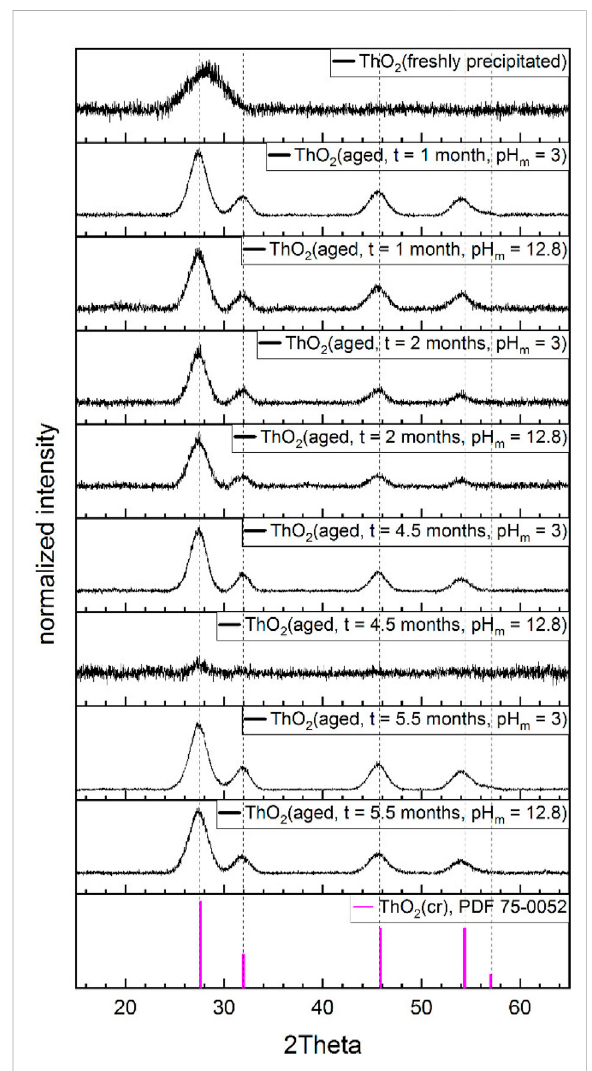
FIGURE 1 Diffractograms of the Th(IV) solid phases synthesized in this work and equilibrated at T = 80 ° C and pH m (25 ° C) = 3 and 12.8, except for the sample “ ThO 2 (freshly precipitated) ” , which was measured 2 days after precipitation. Vertical dashed lines refer to the ThO 2 (cr) reference (PDF 75-0052). The low quality of the diffractogramm obtained for the sample aged for 4.5 months at pH m = 12.8 was caused by the limited amount of solid phase